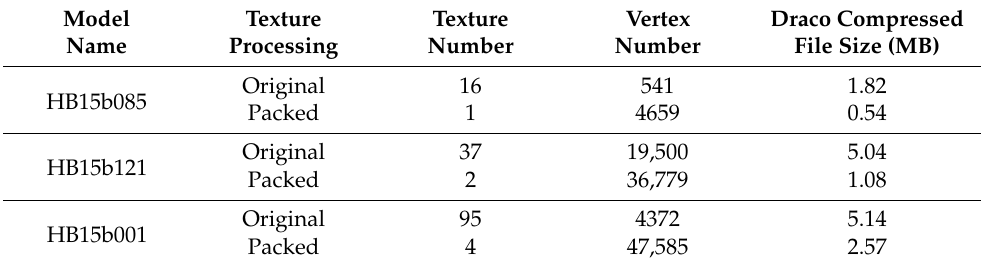
Table 1. Comparison of single models.